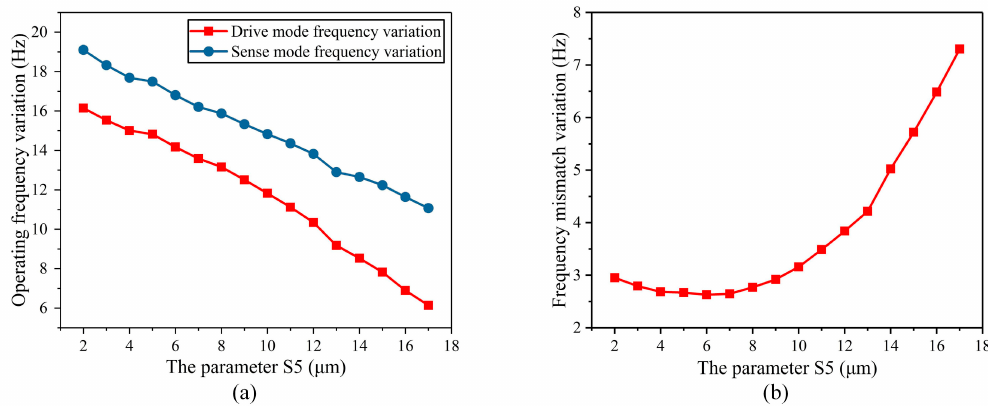
Figure 9. The parameter of the width of the stress-release groove (S 5 ) affected the variation of the operating frequency and frequency mismatch: ( a ) The degree of variation of the operating frequency; ( b ) the degree of variation of the frequency mismatch.